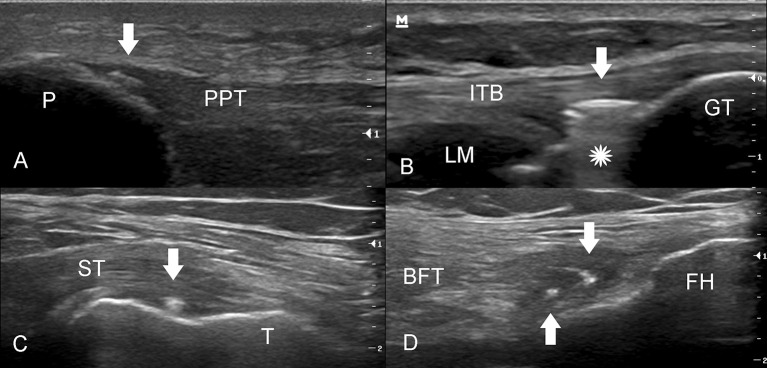
Various attachments of the knee tendons showing signs of intratendinous air (white arrows). (A) The insertion of the proximal patellar tendon (PPT) into the patella (P). The small hyperechogenic focus (arrow) appears with blurred contours and without any acoustic shadow. (B) The long axis of the insertion of the iliotibial band (ITB). The arrow shows the collection of the intratendinous air with a down-ring artifact (star) (Video 4b). GT, Gerdy's tubercle; LM, lateral meniscus. (C) The long axis of semimembranosus tendon (ST) insertion into the posterior aspect of the medial condyle of tibia (T). (D) The common insertion of the biceps femoris tendon (BFT) and lateral collateral ligament (not shown) in the fibular head (FH).